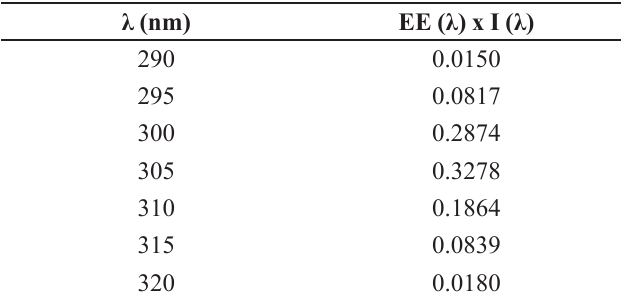
TABLE IV - Relationship between radiation intensity and erythematogenic effect at each